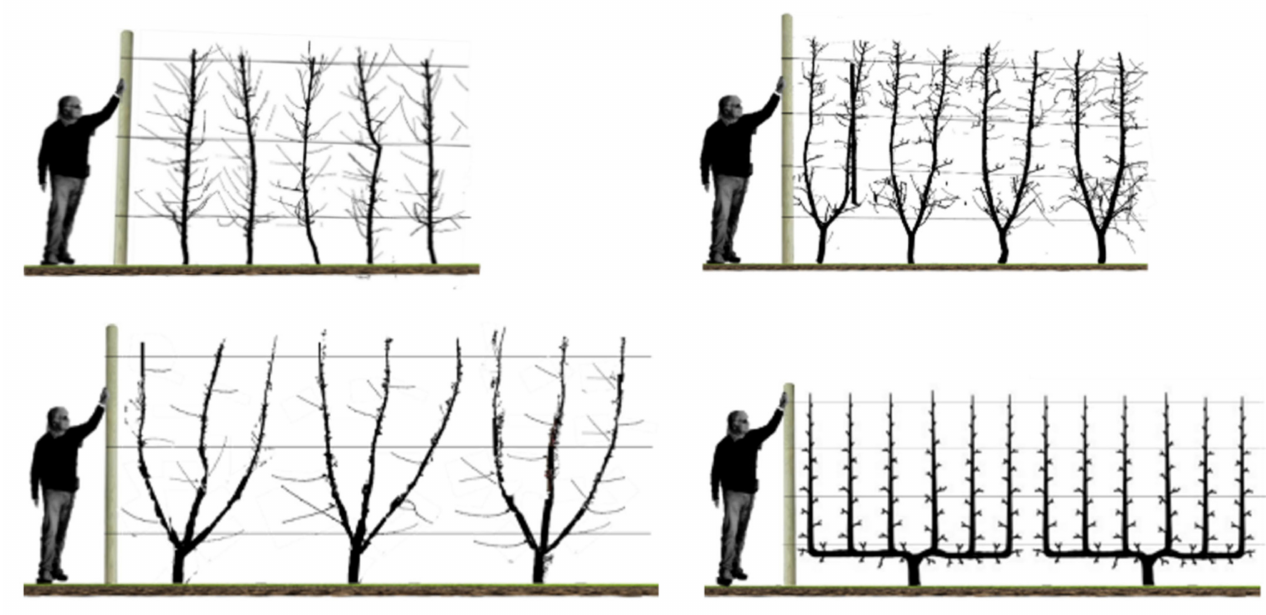
Figure 4. Different options for intensive orchards systems in pear: from the central axis to bi-axis, tri-axis, and